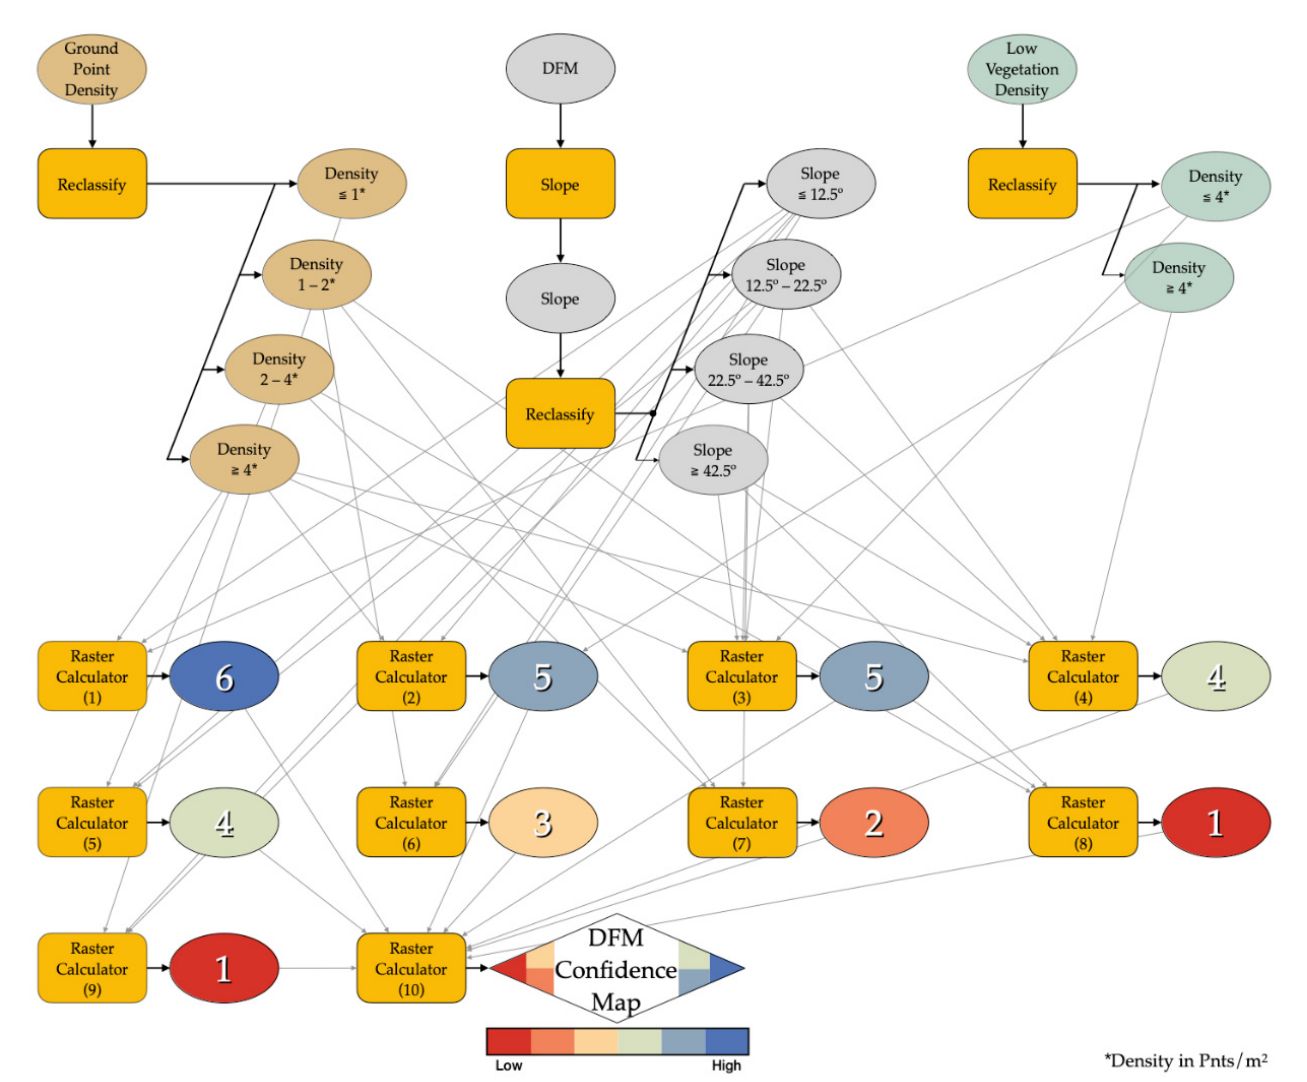
Figure 4. Processing pipeline diagram for a 0.5 m DFM confidence map.